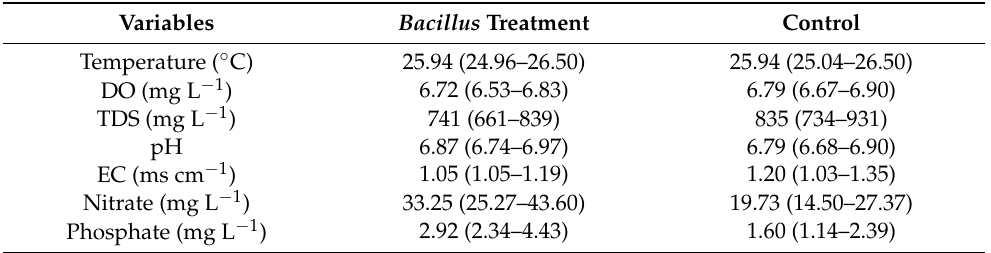
Table 2. Water quality parameters in control and Bacillus probiotic treated systems in the deep-water growth beds. Mean value ranges are given in parentheses.